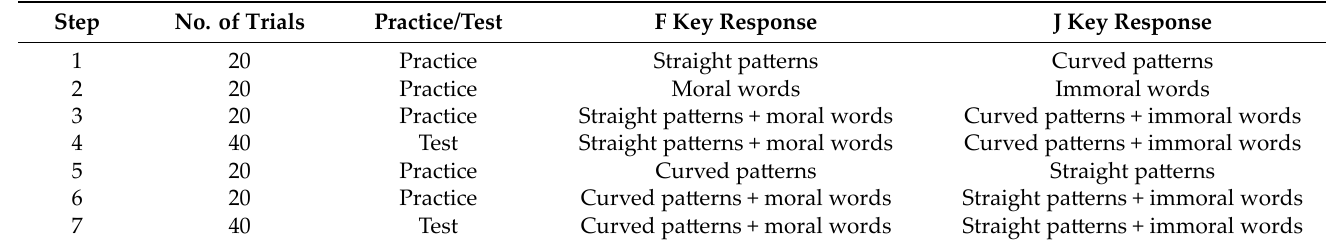
Table 1. The IAT test